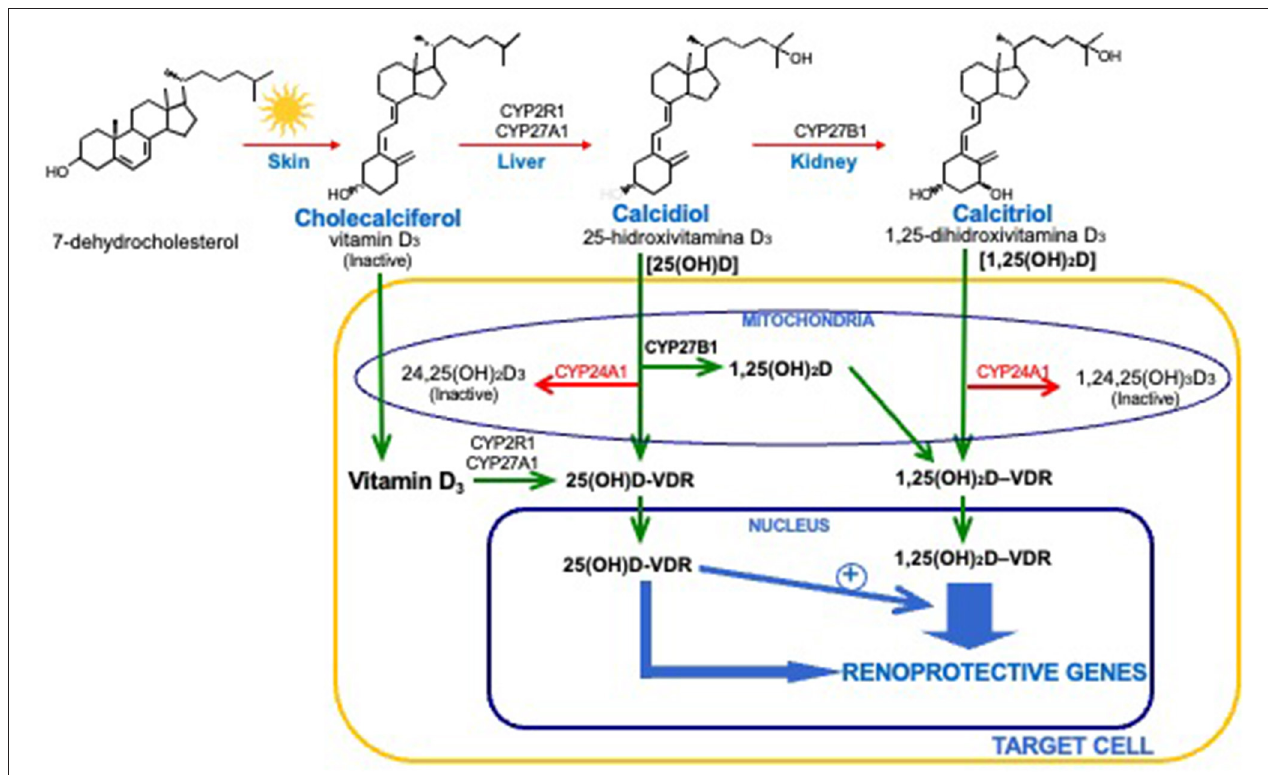
FIGURE 1 | Vitamin D Bioactivation and calcitriol/VDR renoprotective actions. Systemic and intracellular vitamin D activation to 25(OH)D and calcitriol; intracellular balance between activating CYP2R1/CYP27A1 or CYP27B1 with catabolizing CYP24A1 responsible for final 25(OH)D and calcitriol concentrations for VDR binding and activation, and 25(OH)/calcitriol-synergy to enhance calcitriol-VDR transcriptional regulation of renoprotective